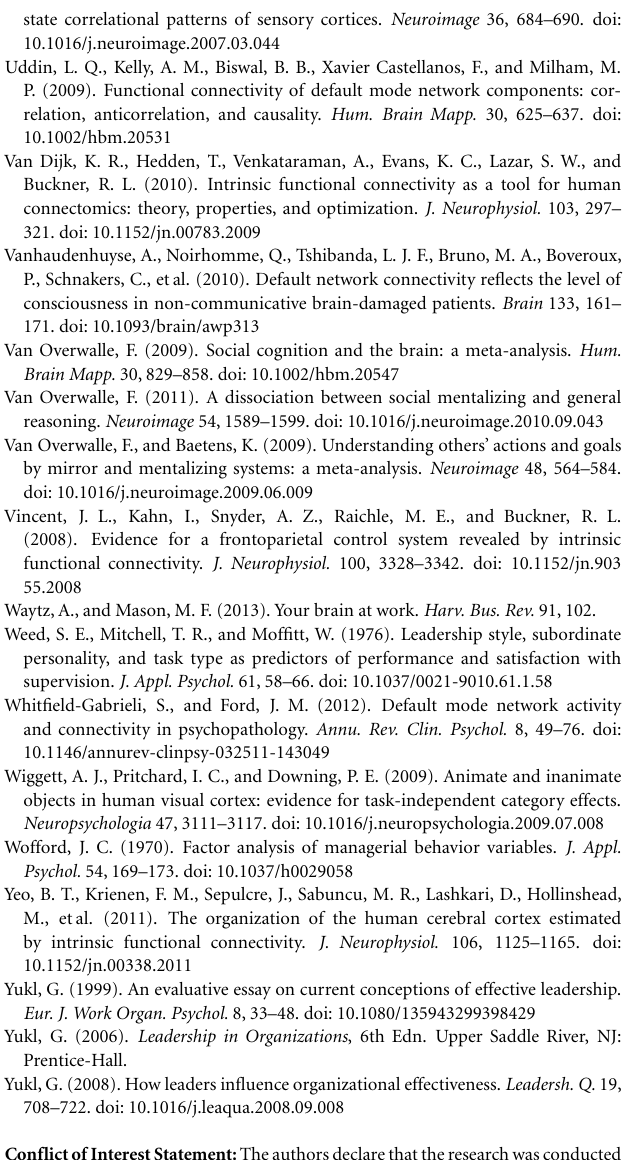
ConflictofInterestStatement: Theauthorsdeclarethattheresearchwasconducted in the absence of any commercial or financial relationships that could be construed as a potential conflict of